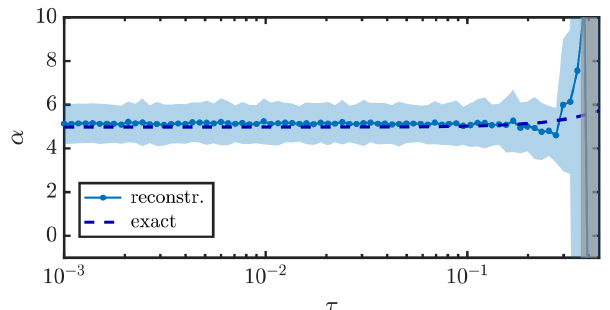
FIG. 8. Overall scale reconstruction. Reconstruction of the overall scale for the first-order learning shown in Fig. 2. The ini- tial state chosen here is a Nèel state evolved up to a total time of n τ = 5, with constraint operator from simulated measurement noise with n s =